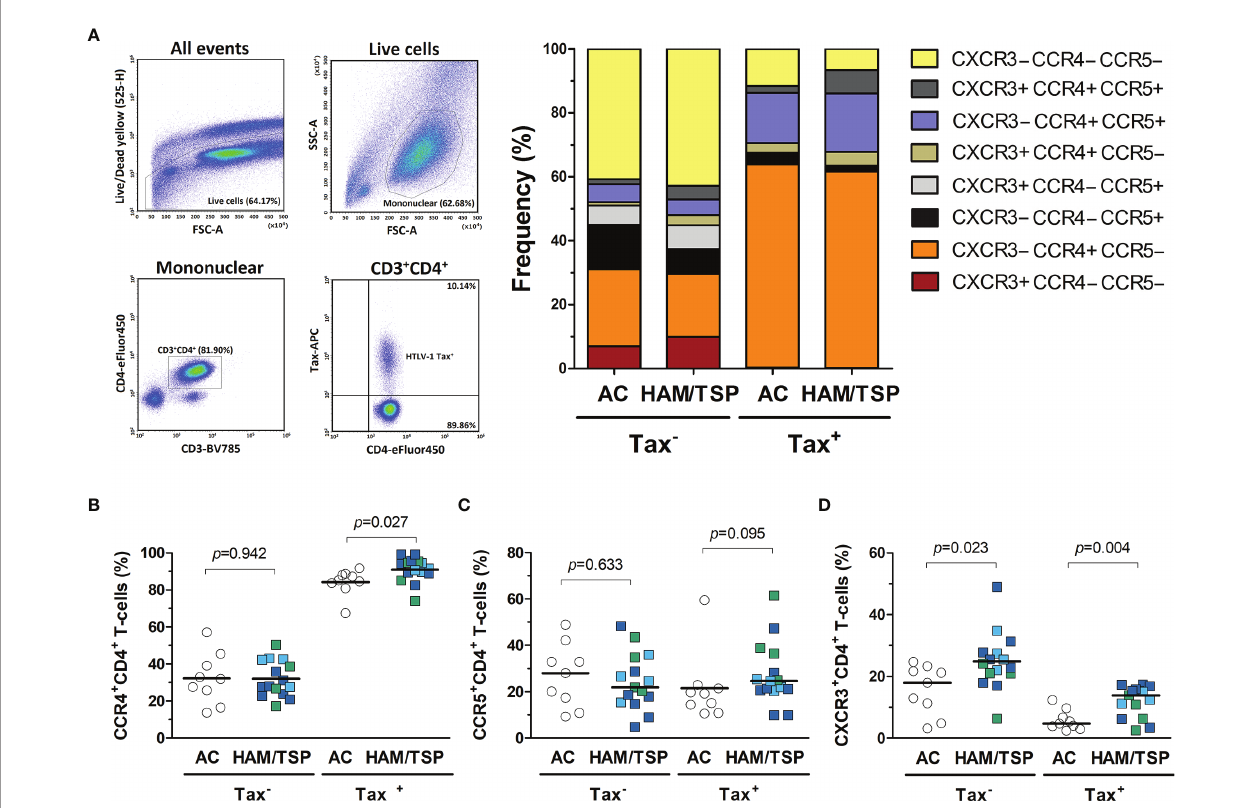
FIGURE 8 | Expression of chemokine receptors by CD4 + T-cells from HTLV-1-infected individuals. (A) Infected (Tax + ) and uninfected (Tax − ) CD4 + T-cells from the peripheral blood of HTLV-1 asymptomatic carriers (AC) (n = 9) and HAM/TSP patients (n = 15) were identi fi ed by fl ow cytometry analysis after intracellular staining of HTLV-1 Tax protein in CD8 + T-cell-depleted PMBCs cultured for 20 h without stimulation. Live cells were gated, and CD3 + CD4 + T-cells were selected within the subset of mononuclear cells. The expression pro fi le of the chemokine receptors CCR4, CCR5, and CXCR3 was evaluated within the subsets of Tax + and Tax − CD4 + T-cells. The frequency of cells expressing (B) CCR4, (C) CCR5, and (D) CXCR3 was determined within the populations of Tax + and Tax − CD4 + T-cells, and the comparison between AC and HAM/TSP patients was performed with Student ’ s t -test. Differences with p -value < 0.05 were considered signi fi cant. HAM/TSP patients were identi fi ed according to the speed of disease progression as very slow (light blue), typical/slow (dark blue) and rapid